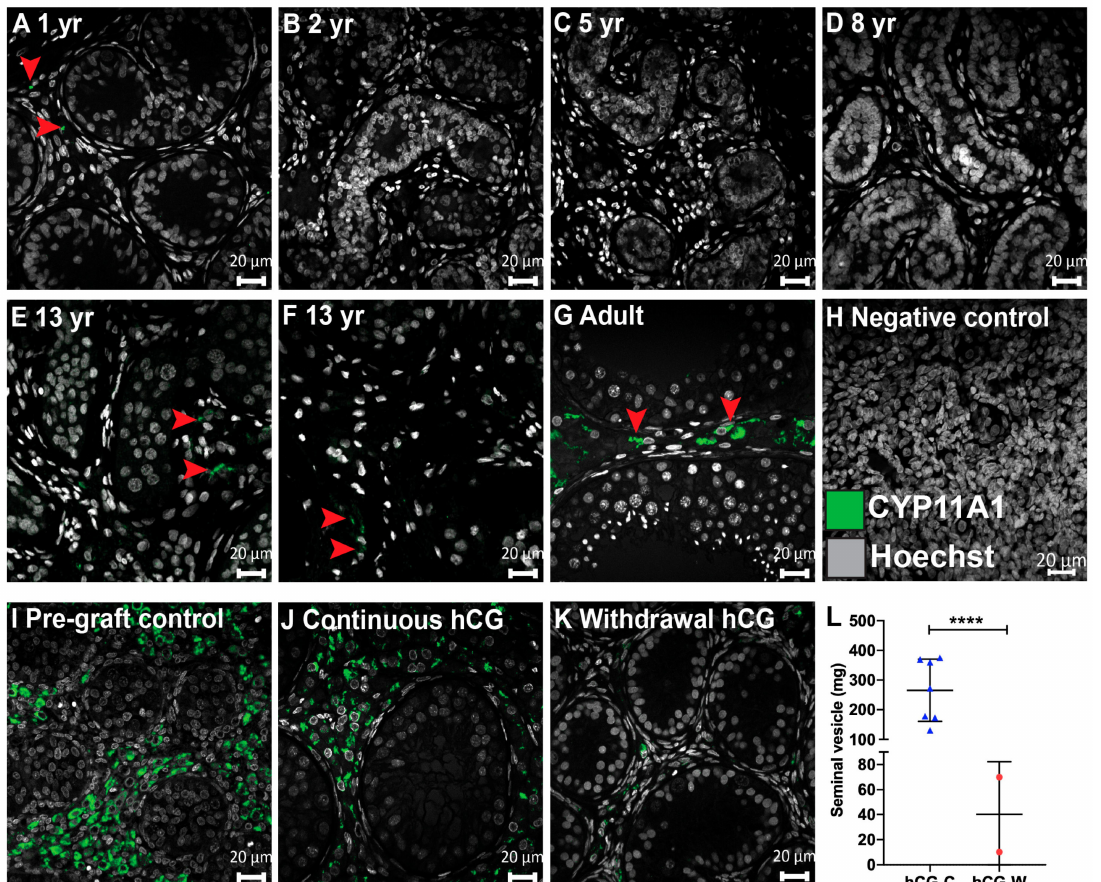
Figure 3. Maintenance of steroidogenesis in long-term continuously hCG-exposed human fetal testis xenografts. ( A – G) The characterisation of CYP11A1 (steroidogenic marker) expression across human testis development. ( H ) Negative control (second-trimester human fetal testis). ( I , J ) Expression of CYP11A1 was observed in all pre-graft control testis tissues (17 GW) and maintained in continuously hCG-treated xenografts (9 months hCG). ( K ) Occasional CYP11A1 + cells were observed in ‘Withdrawal hCG’ grafts (7 months hCG followed by 5 months withdrawal hCG). Images in ( J , K ) are representative of n = 27 and n = 4, respectively. ( L ) The seminal vesicle weight of castrate host mice from the ‘Continuous hCG’ ( n = 7) and ‘Withdrawal hCG’ groups ( n = 2). **** p < 0.0001. The arrowheads point to CYP11A1 + cells. yr: years. Scale bar: 20 µ